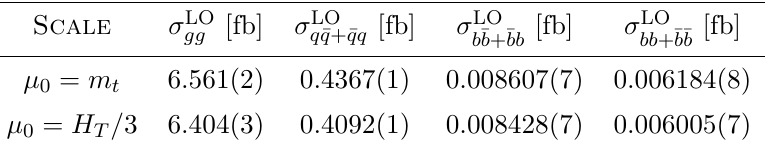
Table 5 . LO integrated fiducial cross section for the pp → e + ν e µ − ¯ ν µ b ¯ b b ¯ b + X production process √ at the LHC with s = 13 TeV for µ 0 = m t and µ 0 = H T / 3 . Theoretical results with and without the initial state b contributions are provided for the LO NNPDF3.1 PDF set. Also given are Monte Carlo integration errors (in